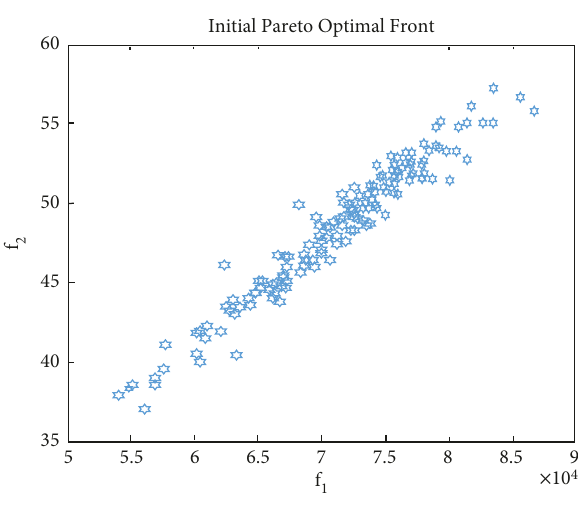
Figure 8: Solution of 100 iterations.